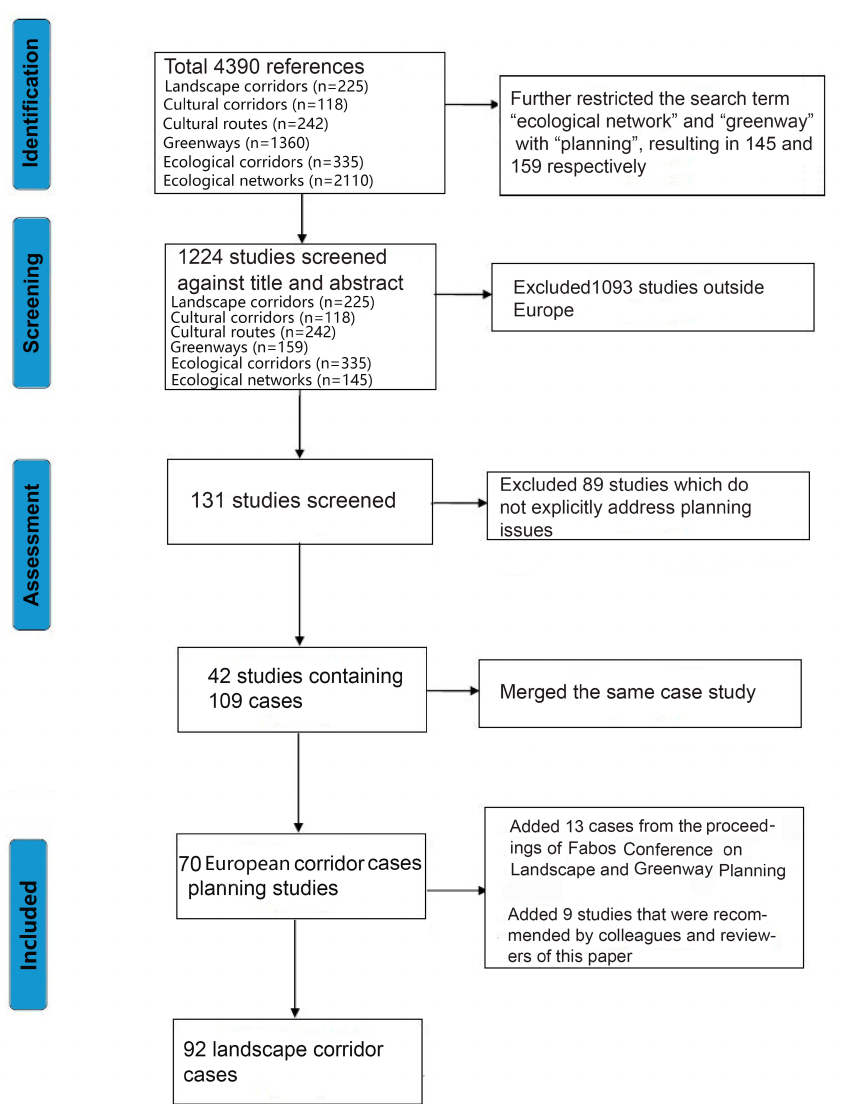
Figure 1. Methodological diagram of the process of selecting cases for systematic review.